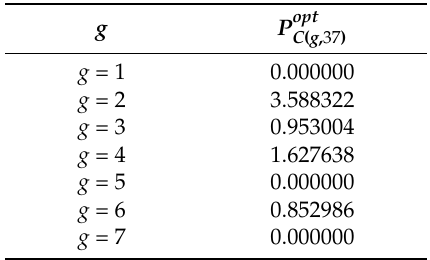
Figure 15. Probability distribution of MLI. Table 7. Power dispatch of CG at t = 37 Table 7. Power dispatch of CG at 𝑡 = 37 h.